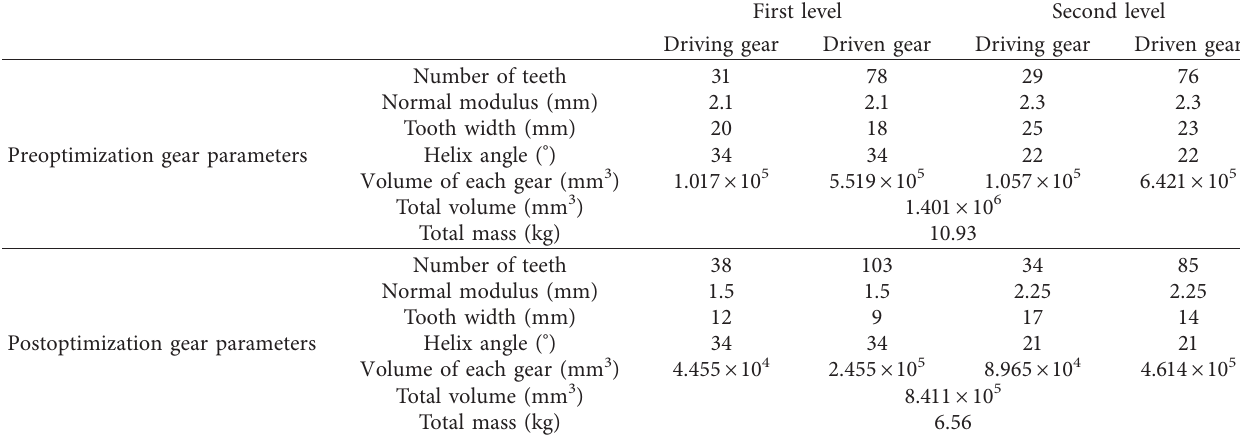
Table 12: Comparison of gears before and after optimization.